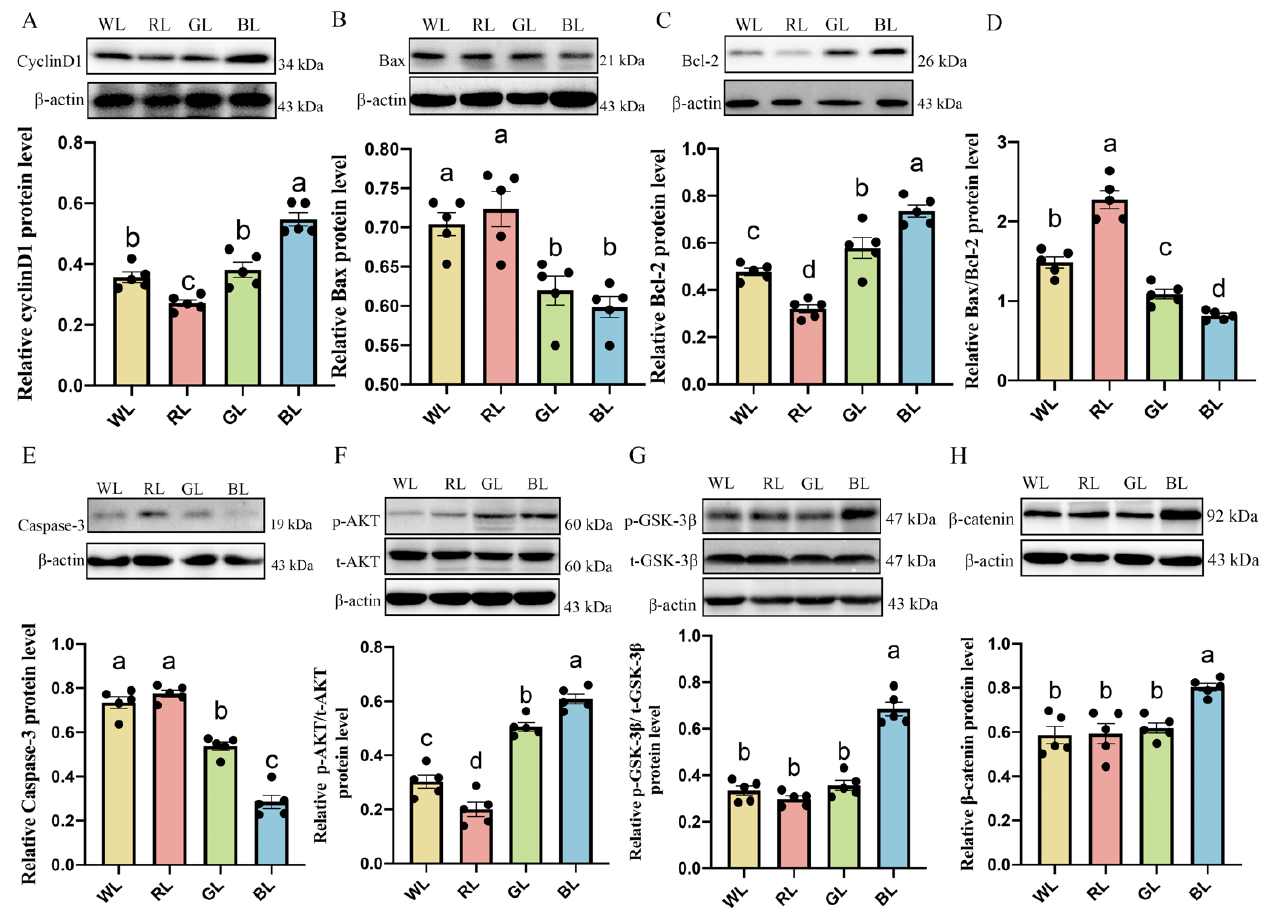
Figure 5. Effects of different monochromatic lights on chick jejunum cyclinD1 protein ( A ), Bax protein ( B ), Bcl-2 protein ( C ), Bax/Bcl-2 ratio ( D ), Caspase-3 protein ( E ) p-AKT/total-AKT ratio ( F ), p-GSK-3 β /total-GSK-3 β ratio ( G ), and β -catenin protein level ( H ) in the jejunums of WL, RL, GL and BL at P42. WL: white light; RL: red light; GL: green light; BL: blue light. These results are shown as means ± SEM. Differences between four groups are presented in the form of different letters ( p < 0.05).